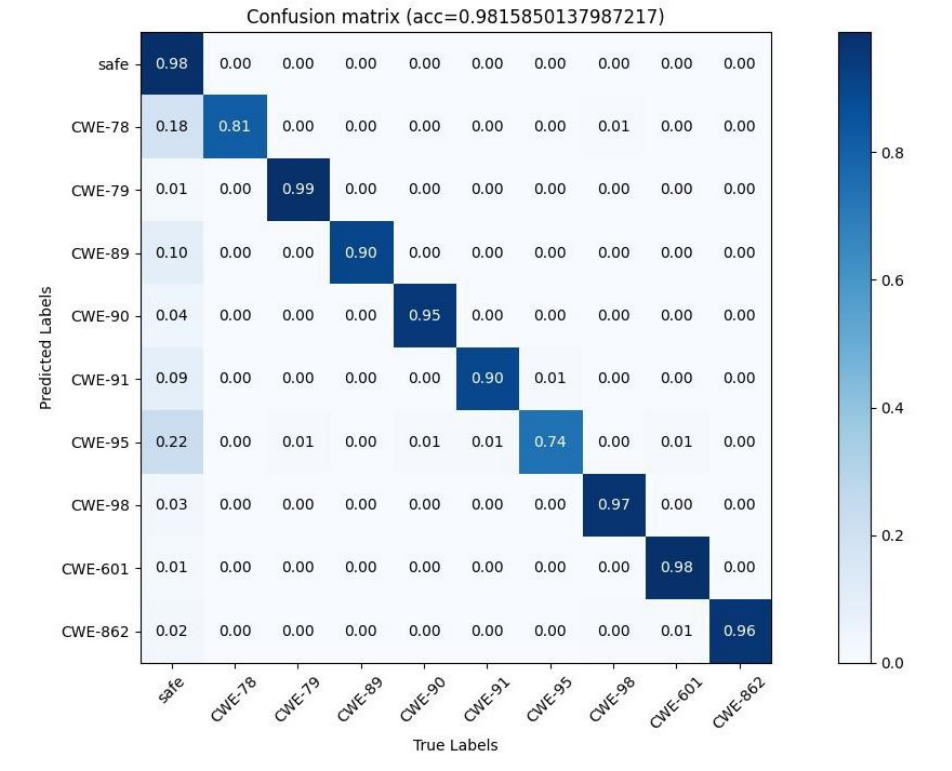
Figure 9. VulEye confusion matrix for multi-classes classification